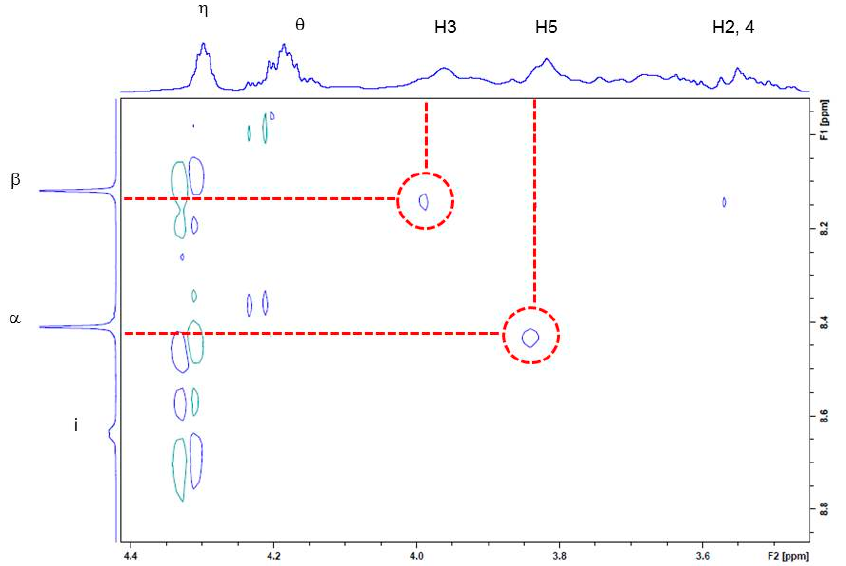
Figure 7. NOESY spectrum of complex ATP/ Zn·1 β (400 MHz, solvent: D 2 O). [ Zn·1 β ] = 5.0 mM, [ATP] = 25 mM.